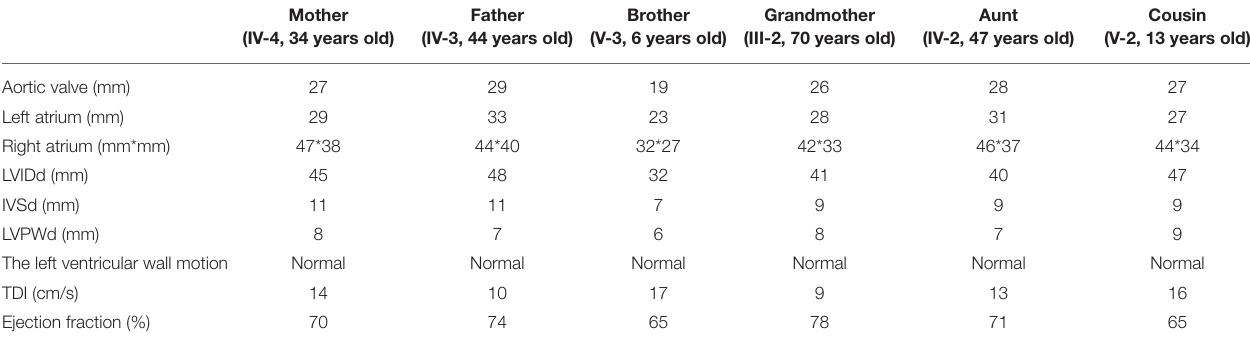
TABLE 2 | Echocardiogram examination of the members in the